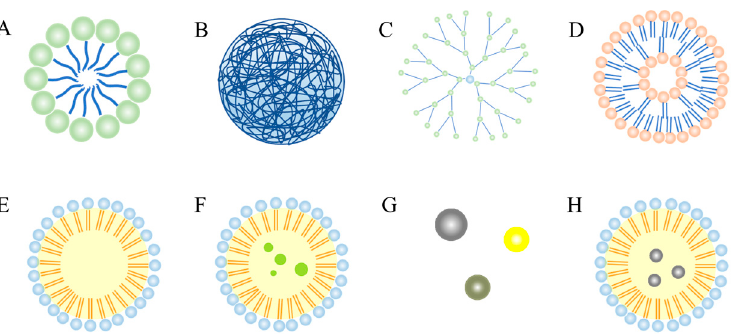
Figure 2. Different types of carotenoids nano-delivery systems for Alzheimer’s disease treatment (( A ): Polymeric micelles; ( B ): Polymeric nanoparticles; ( C ): Dendrimers; ( D ): Liposomes; ( E ): Solid lipid nanoparticles; ( F ): Nanostructured lipid carriers; ( G ): Inorganic nanocarriers; and ( H ): Hybrid nanocarriers).